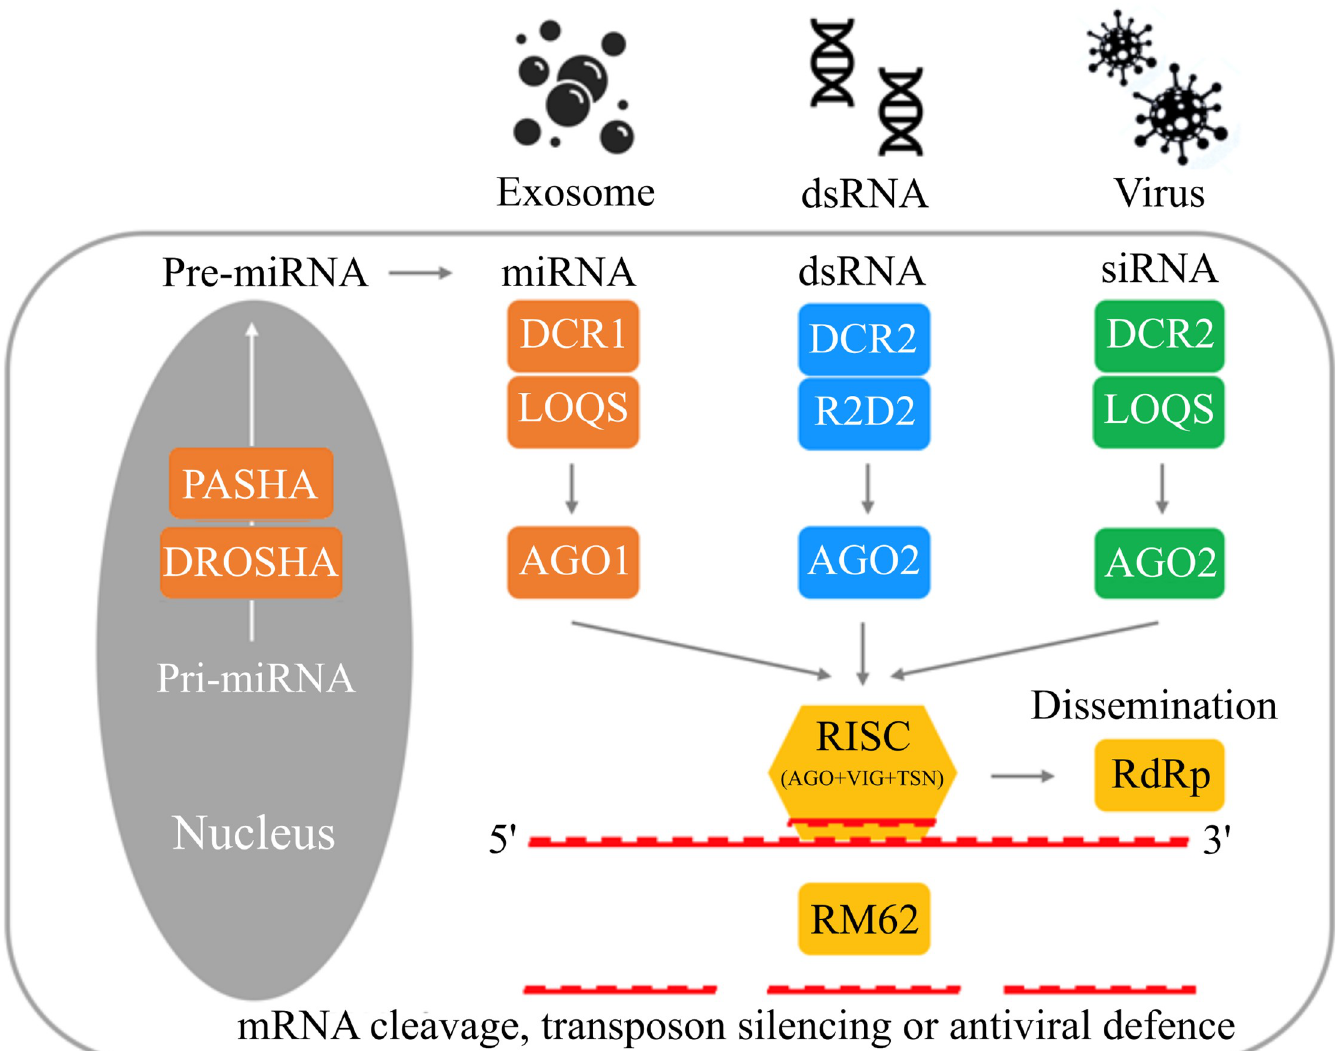
Fig 4. Proposed RNA interference machinery of Sarcoptes scabiei . Proteins PASHA and DROSHA are involved in the endogenous synthesis of miRNA. Endogenous or exogenous miRNA, dsRNA and viral siRNA are recognised and diced by endoribonucleases DCR1 or DCR2, mediated by proteins LOQS or R2D2, and transferred to argonaut protein (AGO1 or AGO2), forming the RNA-induced silencing complex (RISC). The RISC facilitates targeting specific transcripts, leading to mRNA cleavage and antiviral defence via ATP-dependent RNA helicase (RM62). The silencing effect can be disseminated to other cells via a key component RNA-dependent RNA polymerase (RdRp); miRNA, dsRNA and virus-derived siRNA pathways are indicated in orange, blue and green, respectively. Silencing and dissemination modules are indicated in yellow.